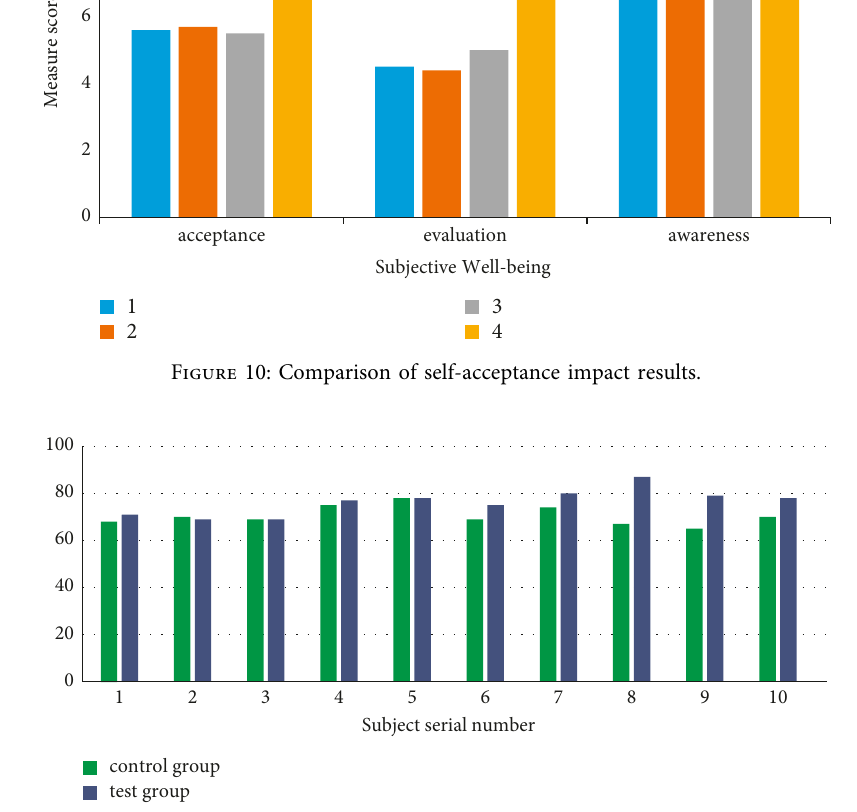
Figure 11: Comparison of self-assessment impact